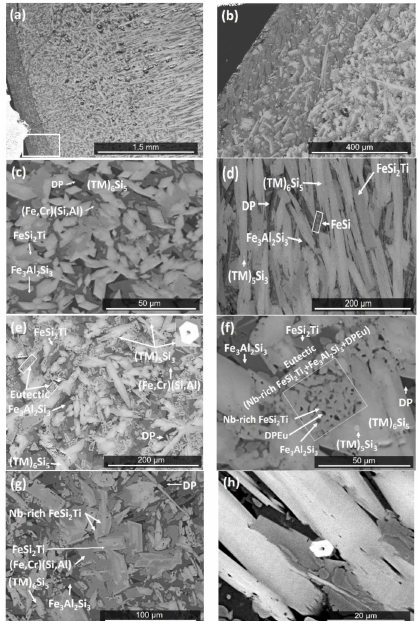
Figure 2. BSE images of OHC2-AC: ( a ) Zone A formed near water cooled copper crucible ( × 40), ( b ) microstructure of area indicated by insert in (a), ( c ) top, ( d ) bulk, ( e ) near bottom, ( f ) near bottom showing eutectic, ( g ) Zone A, and ( h ) bulk showing hexagonal grains of TM 5 Si 3